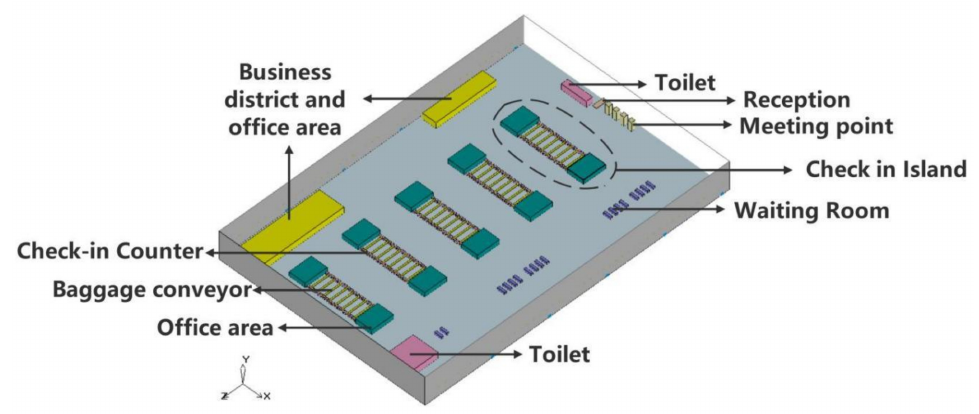
Figure 2. Three-dimensional drawing of 1/2 of the departure